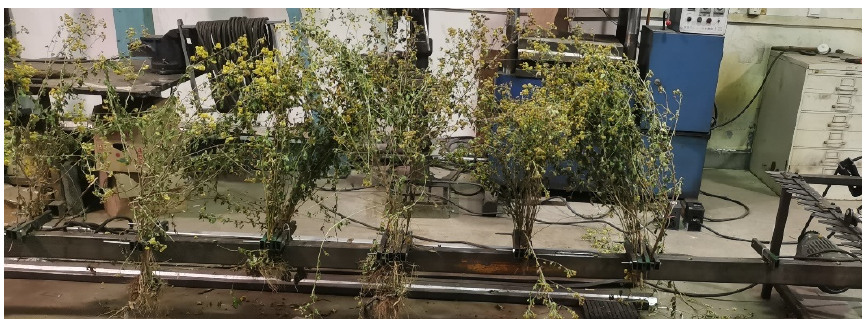
Figure 14. Stem arrangement of chrysanthemum chrysanthemums.